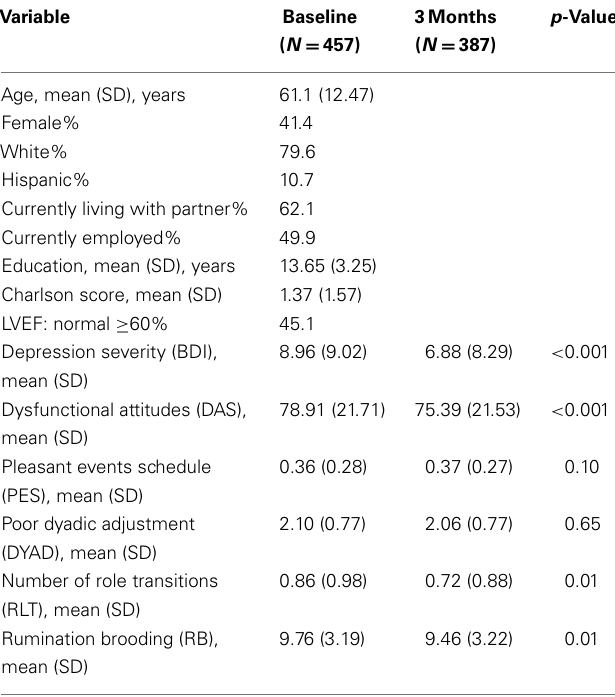
Table 1 | Demographic and psychosocial vulnerabilities of 457 post-acute coronary syndrome patients at baseline and 387 post-acute coronary syndrome patients at